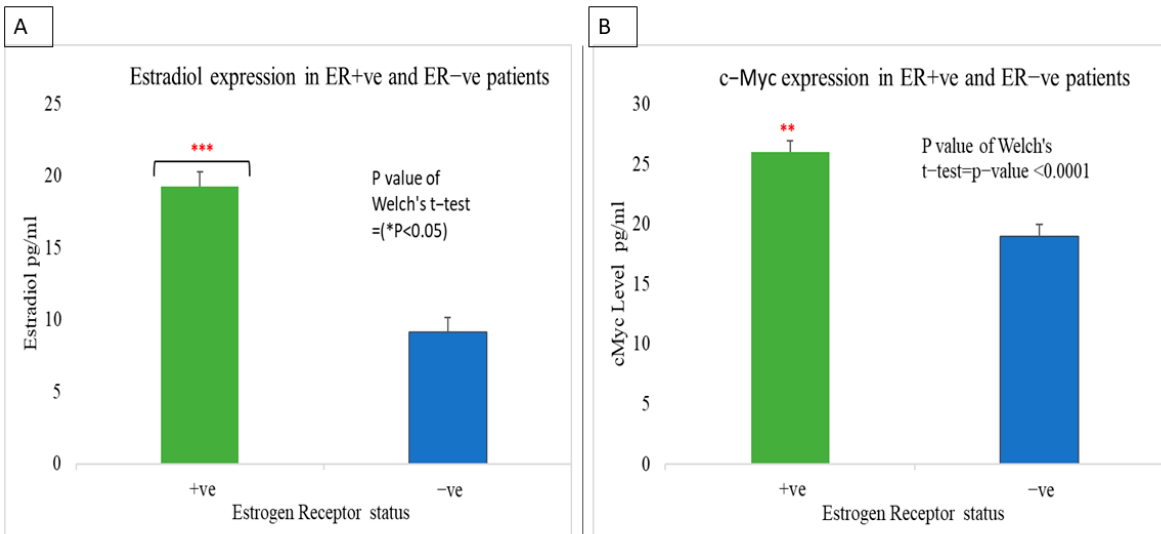
Figure 7. Comparison of estrogen receptor presences in c-myc and estradiol. ( A ) Relationship between estrogen receptor (ER) and c-myc. ER+ve patients showed significantly high level of c-myc expression as compared to ER − ve patients ( p < 0.0025), ( B ) Comparison of mean expression (ME) of ER status and estradiol level in breast cancer patients (RE calculated using Livak method from two-fold Ct values). Error bars indicate standard error of mean. Asterisks indicate a significant difference determined using Welch’s t -test (* p < 0.05). Estradiol level in ER+ve patients (ME = 19.29, n = 14, SD = 4.83, SEM = 1.29) and estradiol level in ER − ve patients (ME = 9.1, n = 15, SD = 6.07, SE = 1.57) showed a significant difference at df = 1, ** = p -value < 0.001. *** = p -value < 0.0001.